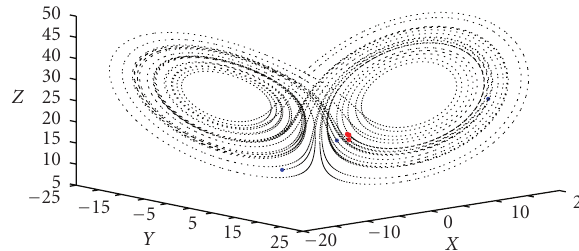
Figure 2: The evolutions of slightly di ff erent initial states in the Lorenz-63 model. Red stars represent initial states; blue circles represent states after 10 seconds. (The figure follows that of Palmer in